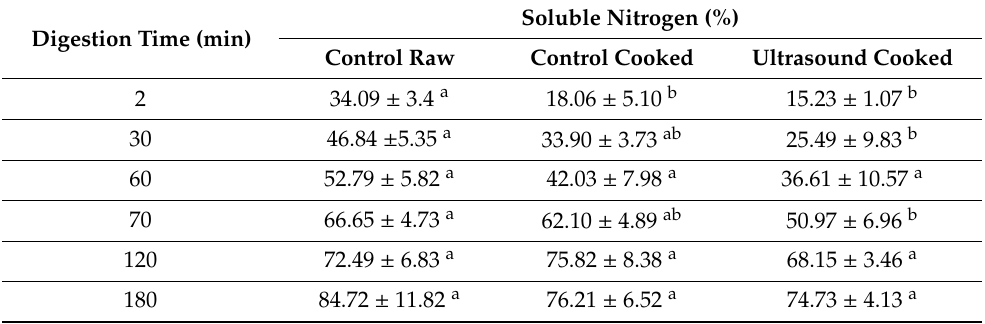
Table 2. Soluble nitrogen (%) of raw and cooked control, and cooked ultrasound pre-treated p¯aua after 2, 30, 60, 70, 120 and 180 min of in vitro oral and gastro-small intestinal digestion. Digestion Time